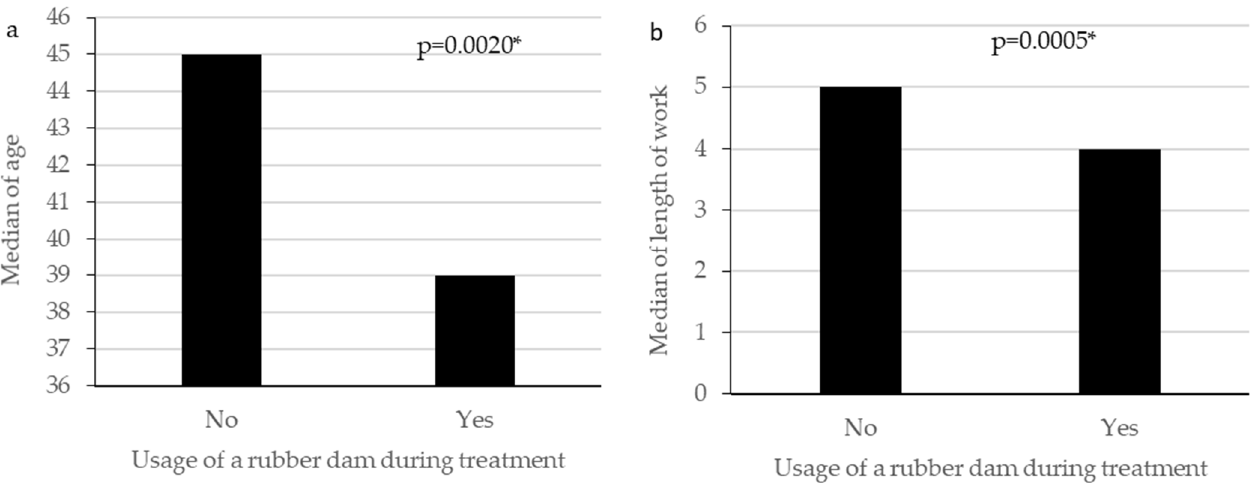
Figure 1. Relationships between usage of a rubber dam during treatment and age ( a ), length of work ( b ), the Mann–Whitney test (* statistically significant p < 0.005).